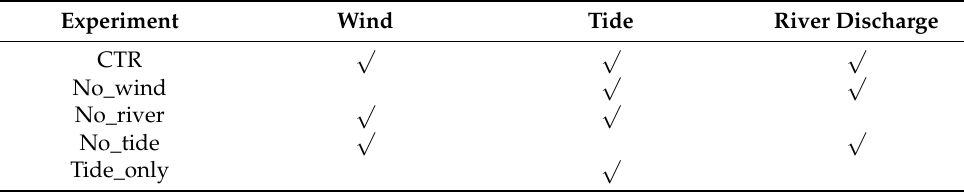
Table 1. Model setup for the sensitivity